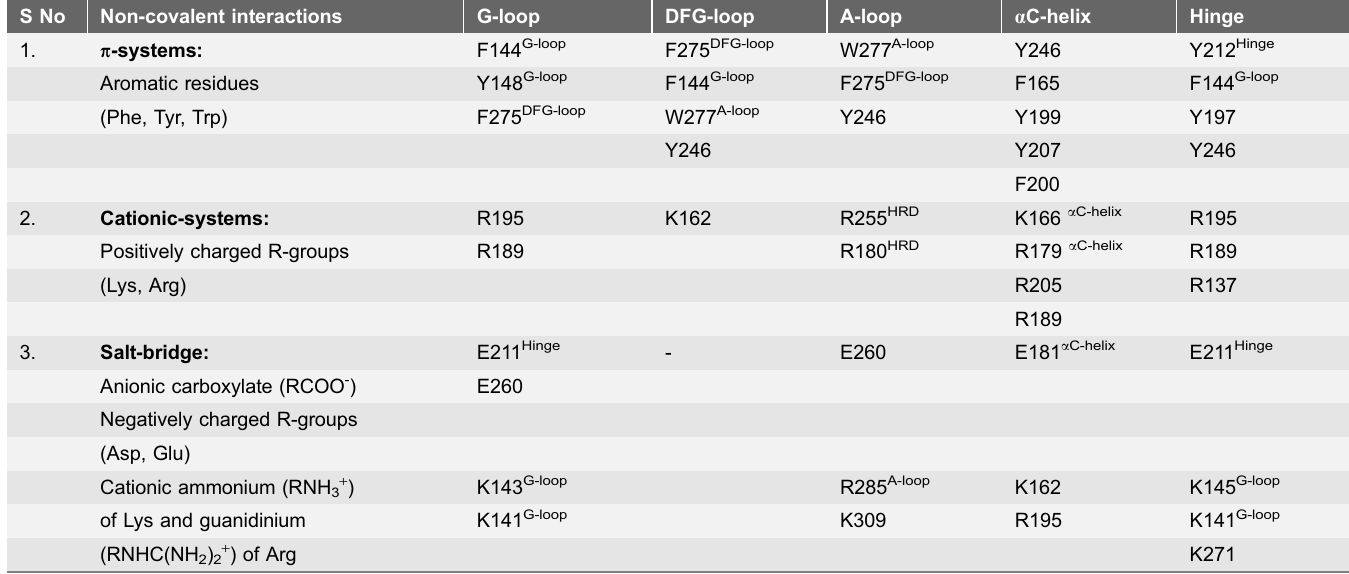
Table 2. Amino acid residues of AK which form important non-covalent interactions required for the conformational stability of the receptor and binding of inhibitors. S No